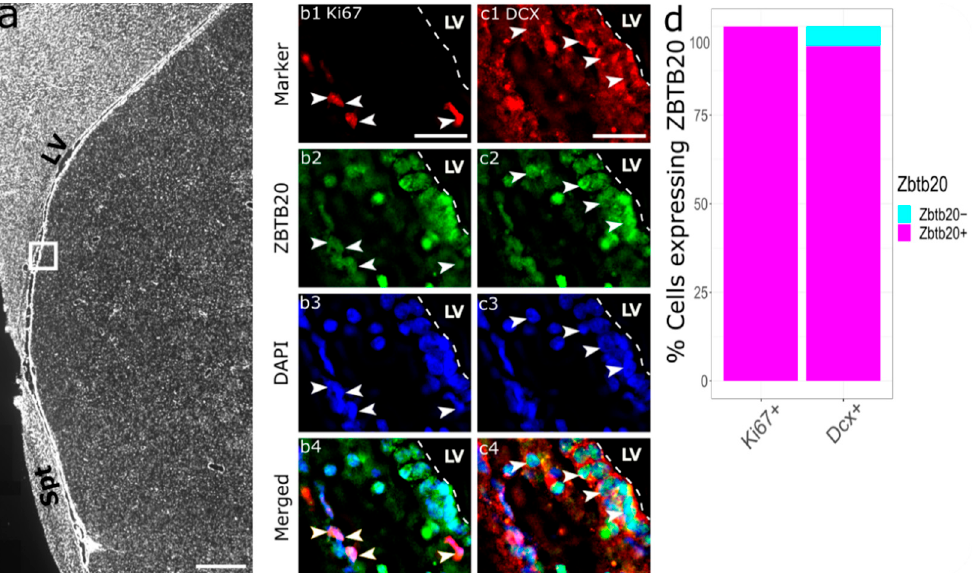
Figure 5. Phenotypic characterization of ZBTB20+ cells in the postischemic primate SVZa. ( a ) Low magnification image showing the relative position of the higher magnification micrographs panels ( b – c ); ( b1 – b4 ) arrowheads depict Ki67+/ZBTB20+ cells.; ( c1 – c4 ) DCX/ZBTB20 co-staining demonstrates the presence of numerous double-labeled cells (arrowheads); ( d ) stacked bar plot summarizing the percentage of ZBTB20 co-expression by specific cell populations defined by the markers shown on the plot; CC—corpus callosum; LV—lateral ventricle; Spt—septum. Scale bar: 1 mm ( a ), 25 μ m ( b , c ).